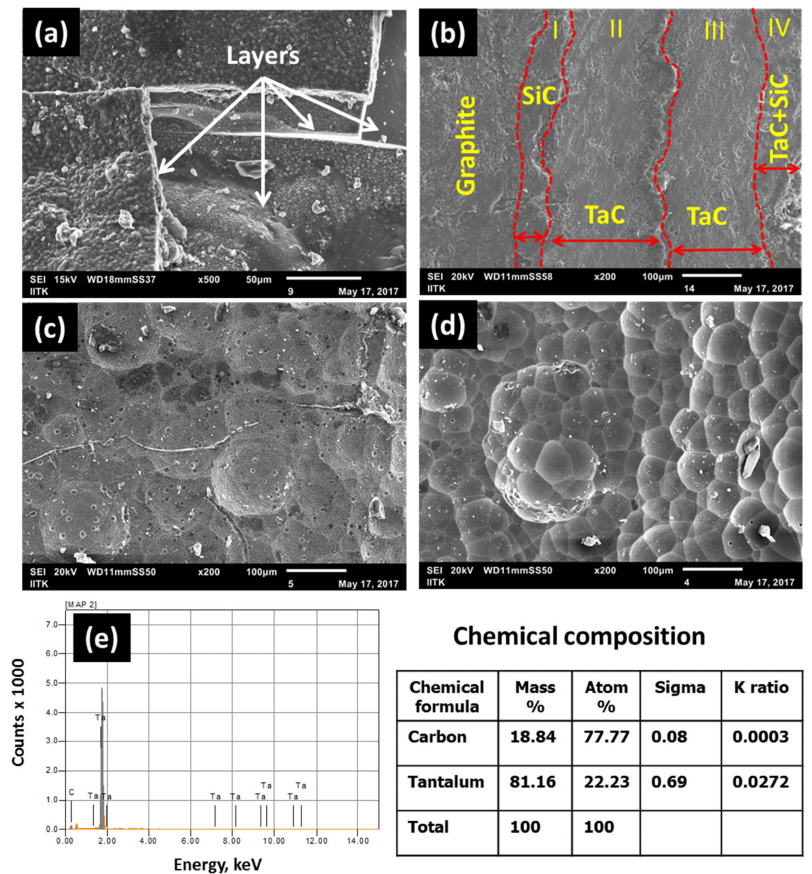
Figure 2. As-deposited TaC coating surface morphology and Energy Dispersive X-ray Spectroscopy (EDAX) analysis: ( a ) Optical image of the coated sample which shows the four layers; ( b ) SEM image to show through-thickness coating layers; ( c ) coating mophology at 1050 ◦ C, 100 mbar; ( d ) coating mophology at 1150 ◦ C, 100 mbar; ( e ) Energy Dispersive X-ray Spectroscopy spectra of the as-deposited TaC